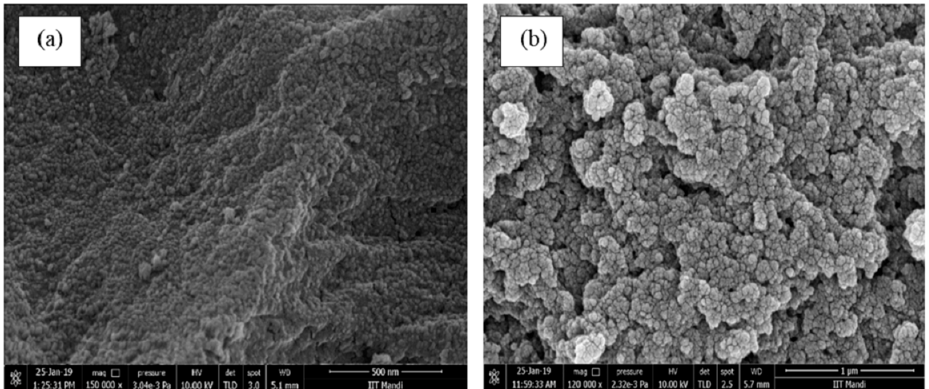
Figure 2. SEM images of MOGN ( a ) and DOX–MOGN ( b ).